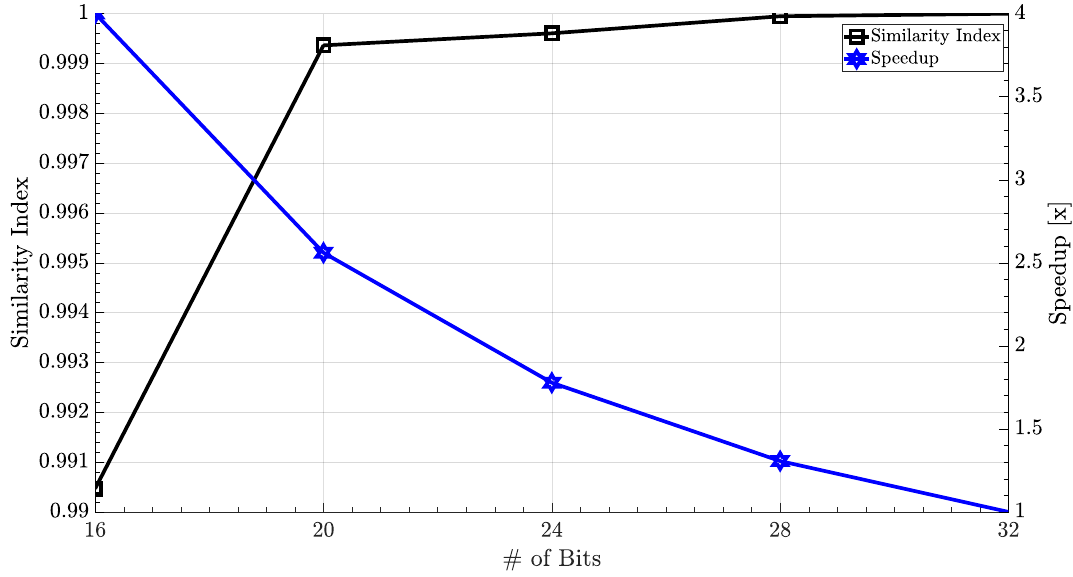
Figure 8. Results of approximate stencil code on the